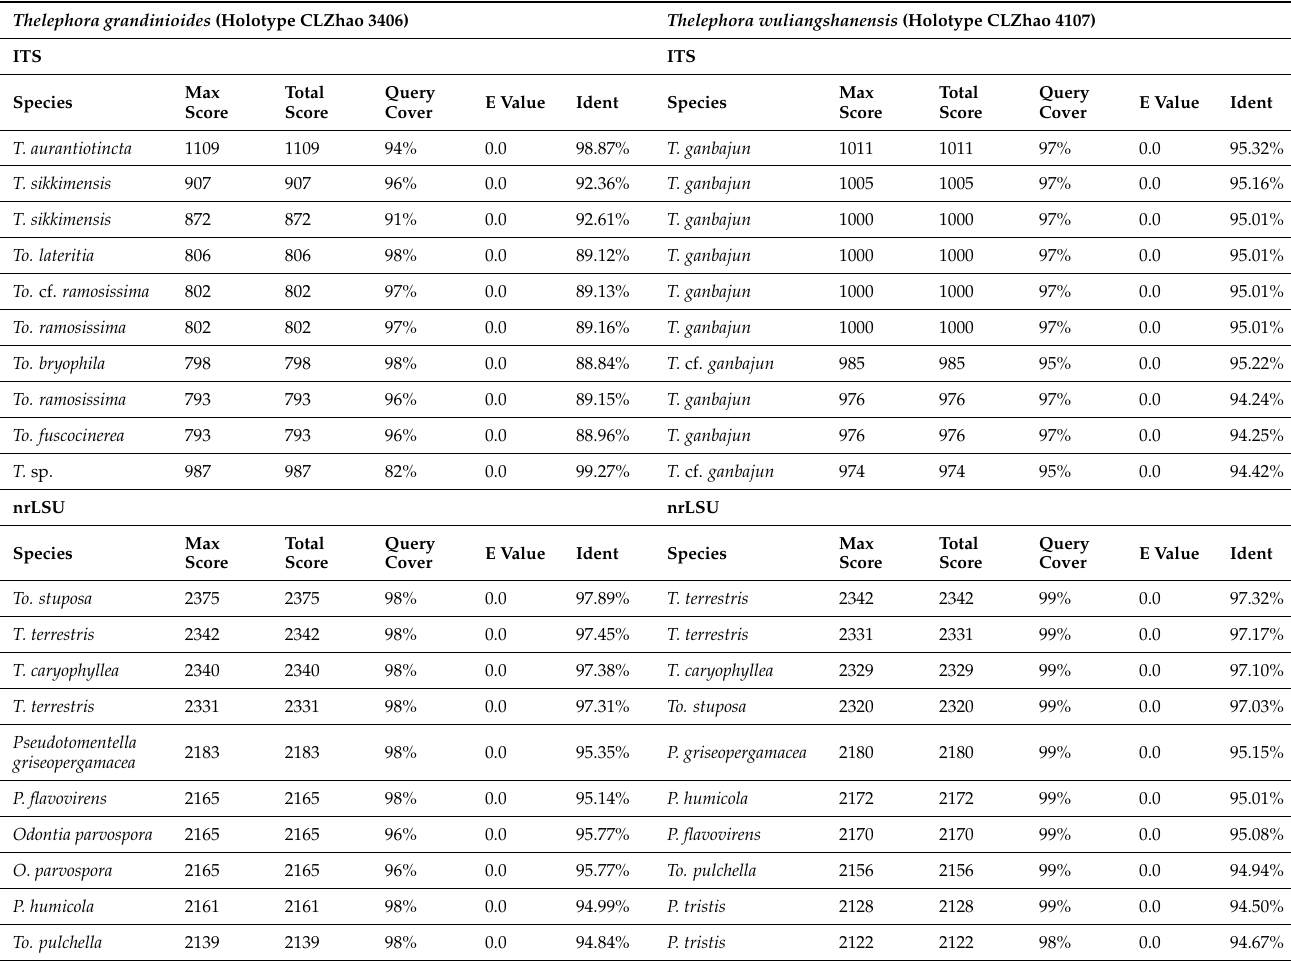
Table 3. The top ten species results of Blast search of Thelephora grandinioides and T. sikkimensis sequences. Thelephora grandinioides (Holotype CLZhao